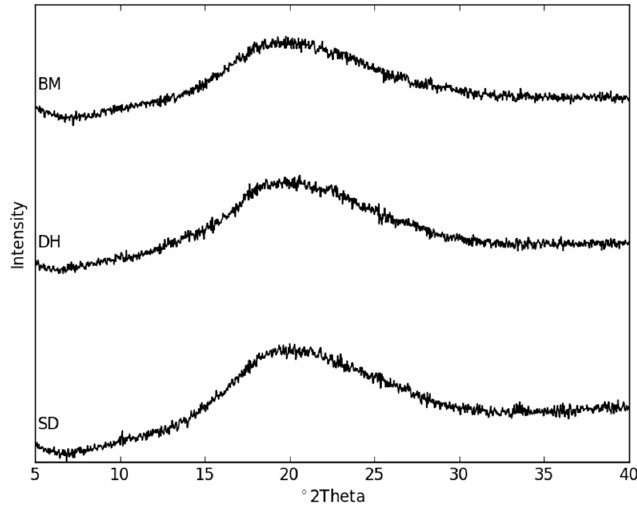
Figure 5. X-ray powder diffraction patterns of the freshly prepared co-amorphous BM, DH, and SD samples.